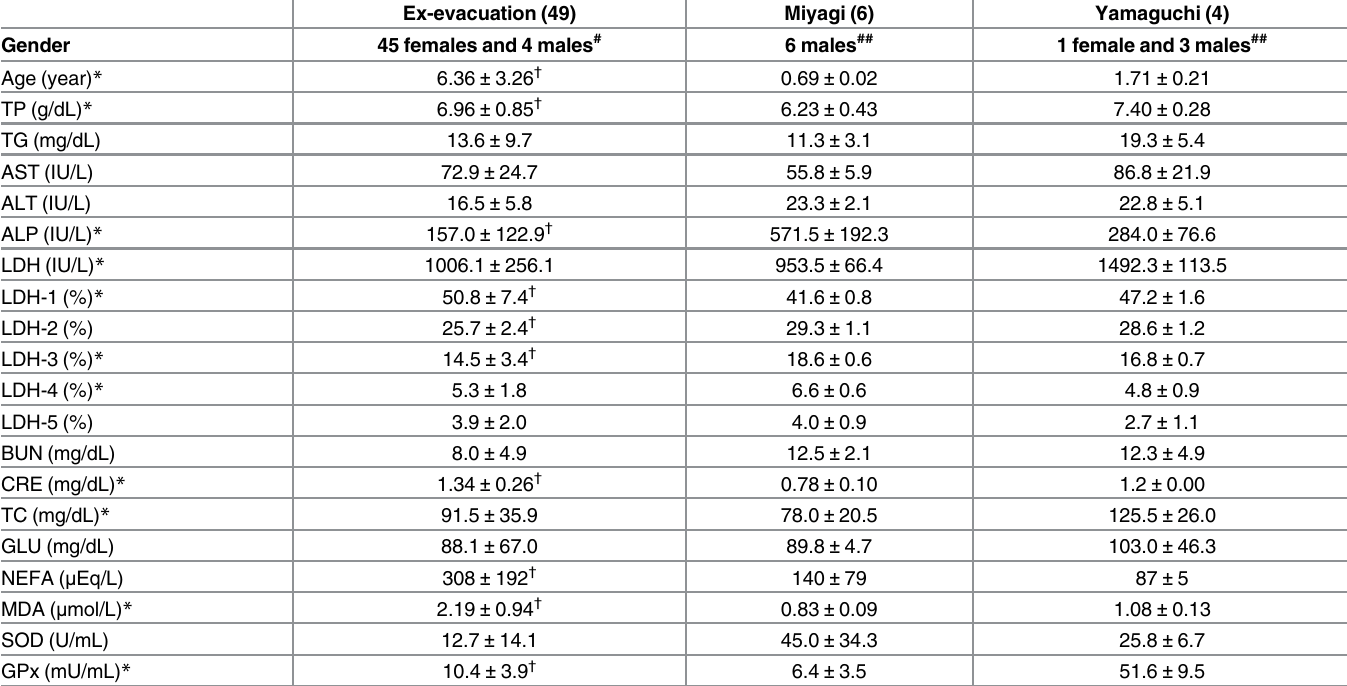
Table 1. Plasma protein concentrations and enzyme